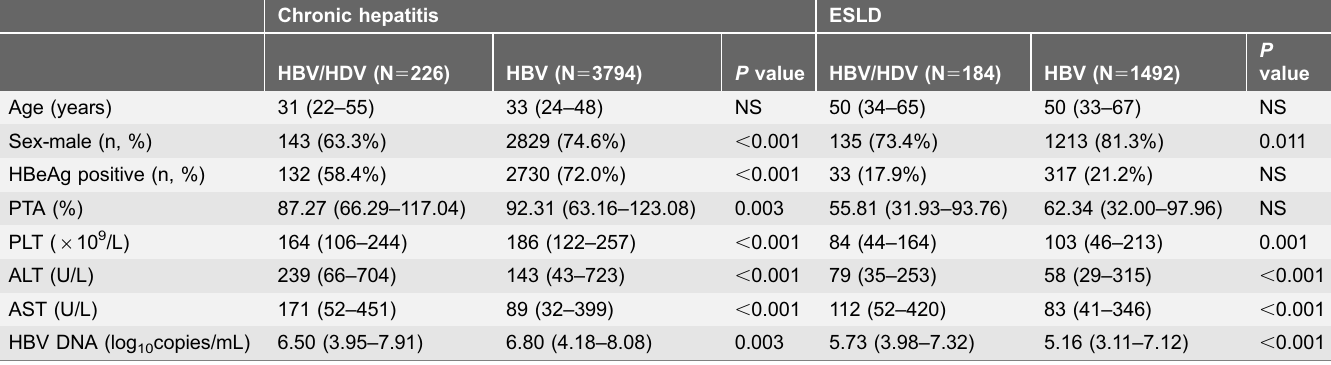
Table 2. Characteristics of HBV/HDV co-infected patients with chronic hepatitis and